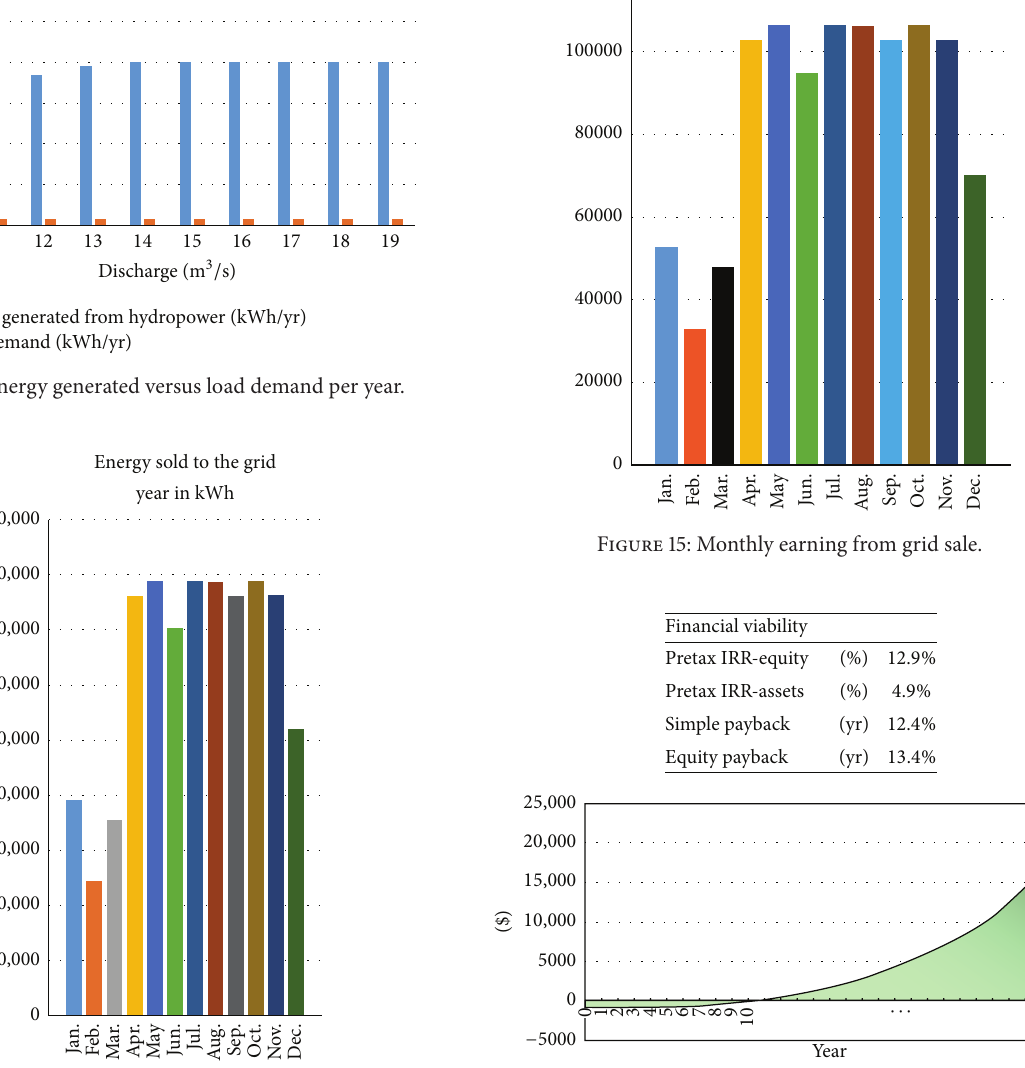
Figure 14: Energy sold to the grid in each month of the year.